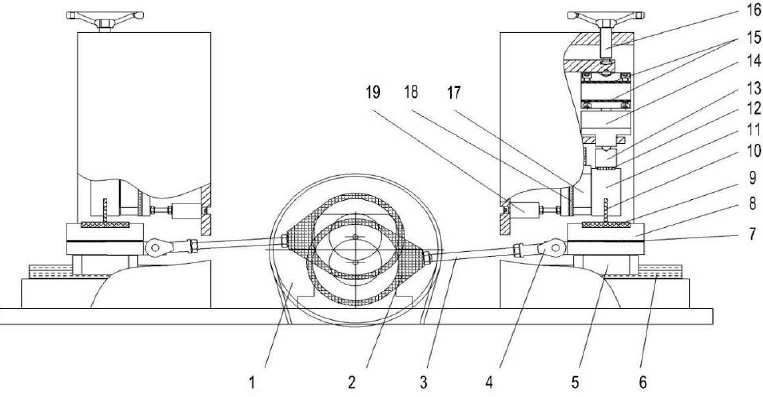
Figure 8. The geometry of the tribotester: 1—Belt pulley, 2—Eccentric shaft, 3—Connecting rod, 4— Knuckle bearing, 5—Sliding block, 6—Guide rail, 7—Thermal baffle, 8—Heater, 9—Al–Si alloy cylinder liner sample, 10—CKS piston ring sample, 11—Pressure head, 12—Roller pin, 13—Self-